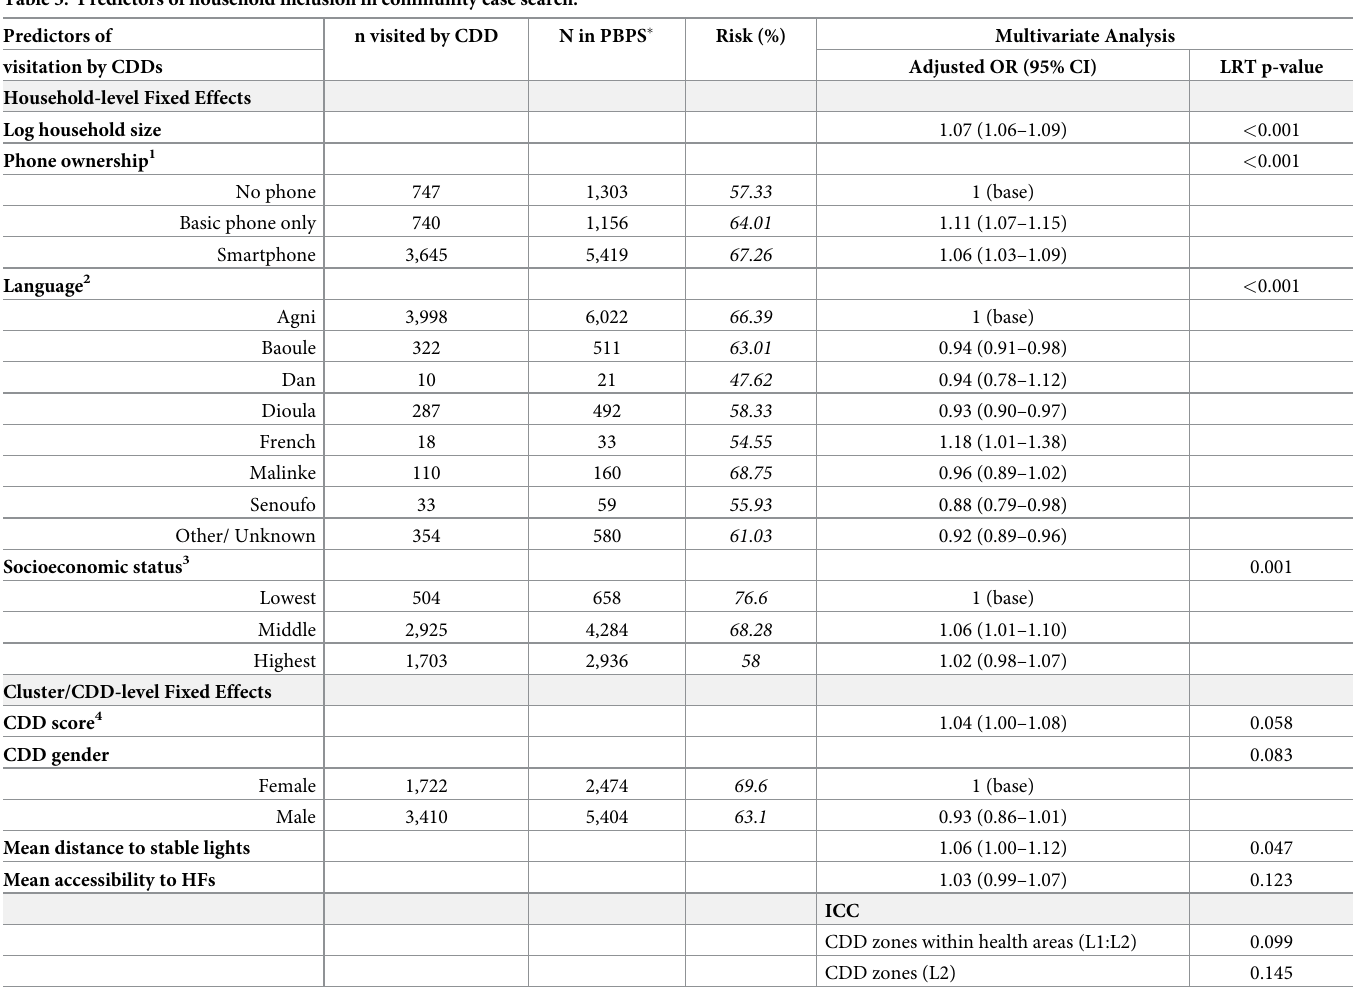
Table 3. Predictors of household inclusion in community case